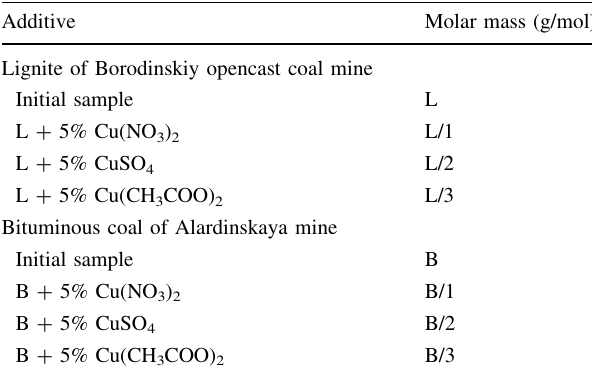
Table 2 The list of synthesized samples and their labels Additive Molar mass (g/mol)